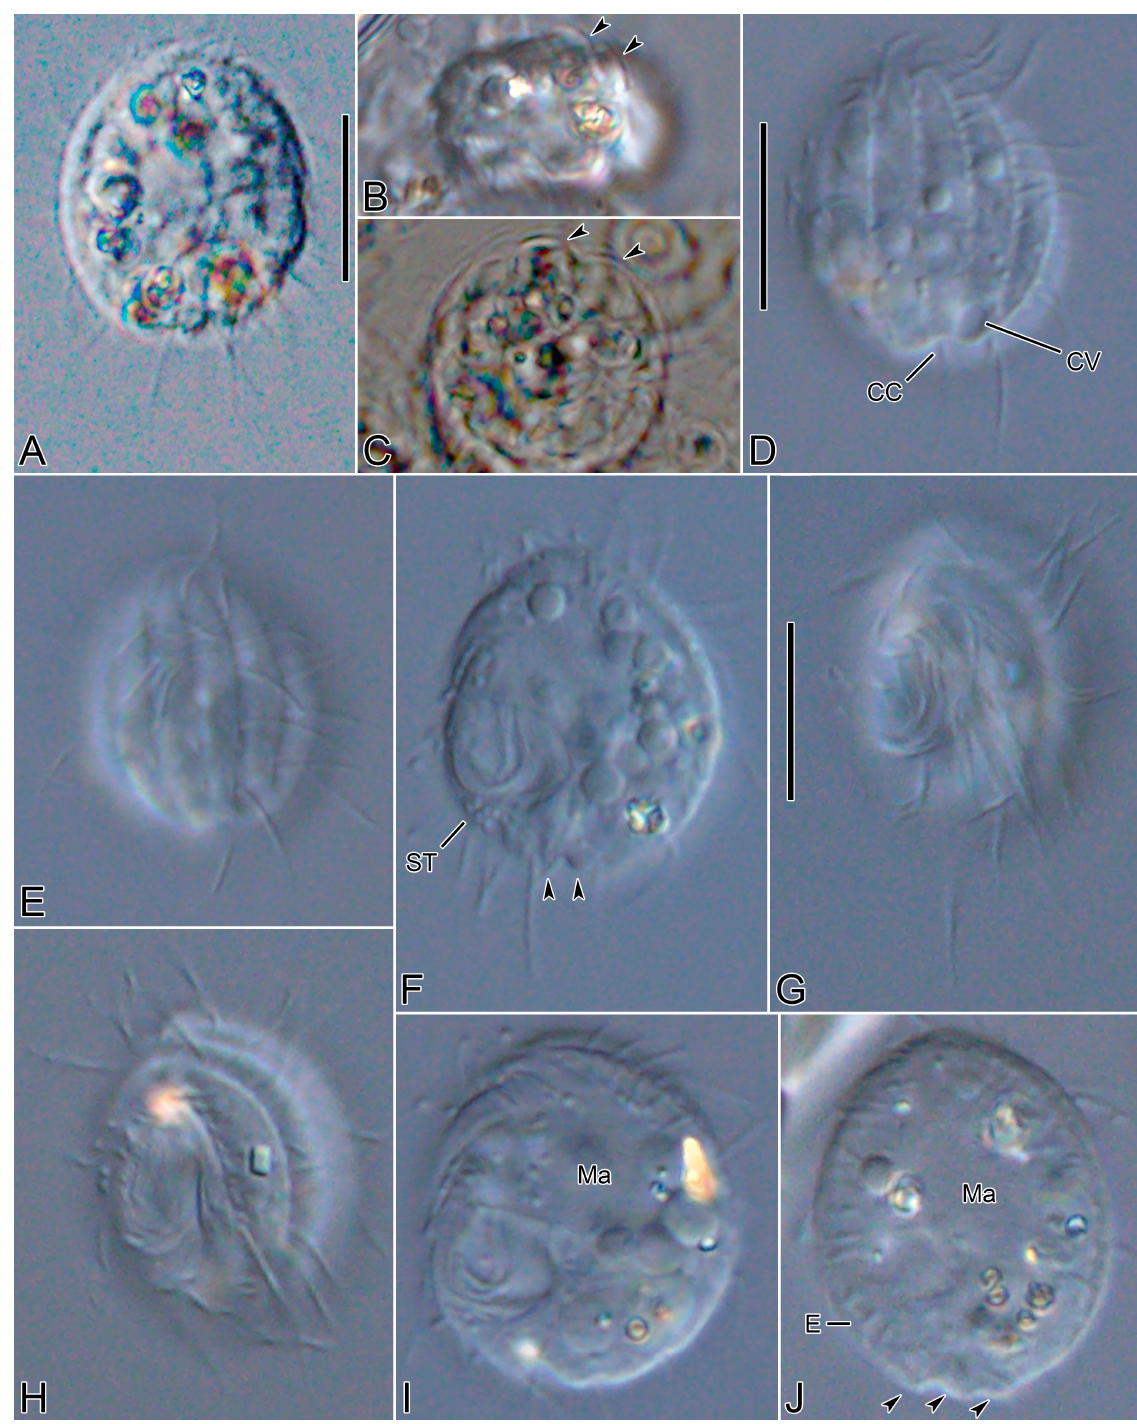
Figure 3. Cinetochilides minimus sp. nov. from life. ( A ). Ventral view showing the body shape, cilia, and cytoplasmic inclusions. ( B , C ). Apical views showing the dorsal ridges (arrowheads). ( D , E ). Dorsal views showing the contractile vacuole and cilia. Note that posterior ends of dorsal kineties are partially non-ciliated and the caudal cilium has an ordinary length like other somatic cilia. ( F – J ). Ventral views showing indistinct notches ( F , J , arrowheads), nuclear apparatus ( I , J ), extrusomes ( I , J ), cytoplasmic crystals ( H ), and cilia ( G ). Note that the longest cilia originate from posterior ends of ventral kineties. CC, caudal cilium; CV, contractile vacuole; E, extrusomes; Ma, macronuclear nodules; ST, scutica. Scale bars: 10 µ